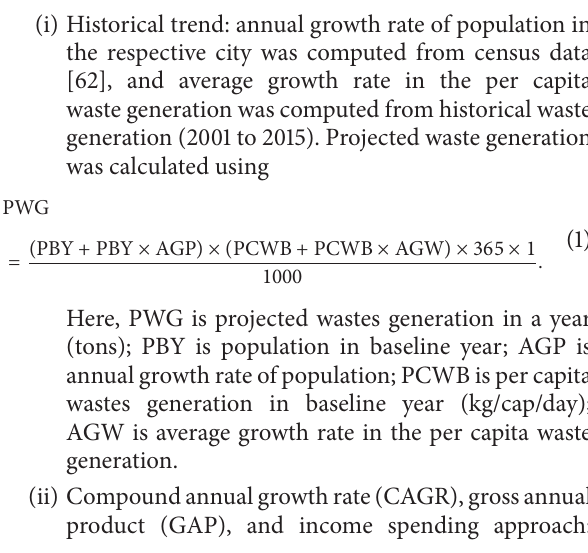
segregation of MSW at the solid waste disposal sites